Question: Based on the figure, does the quantity rise or fall?
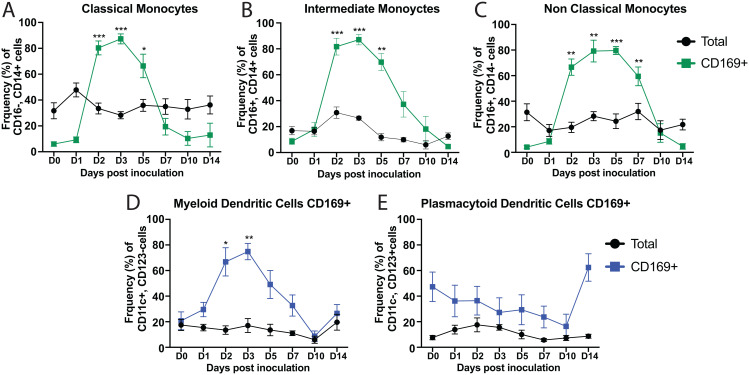
Answer: increasing